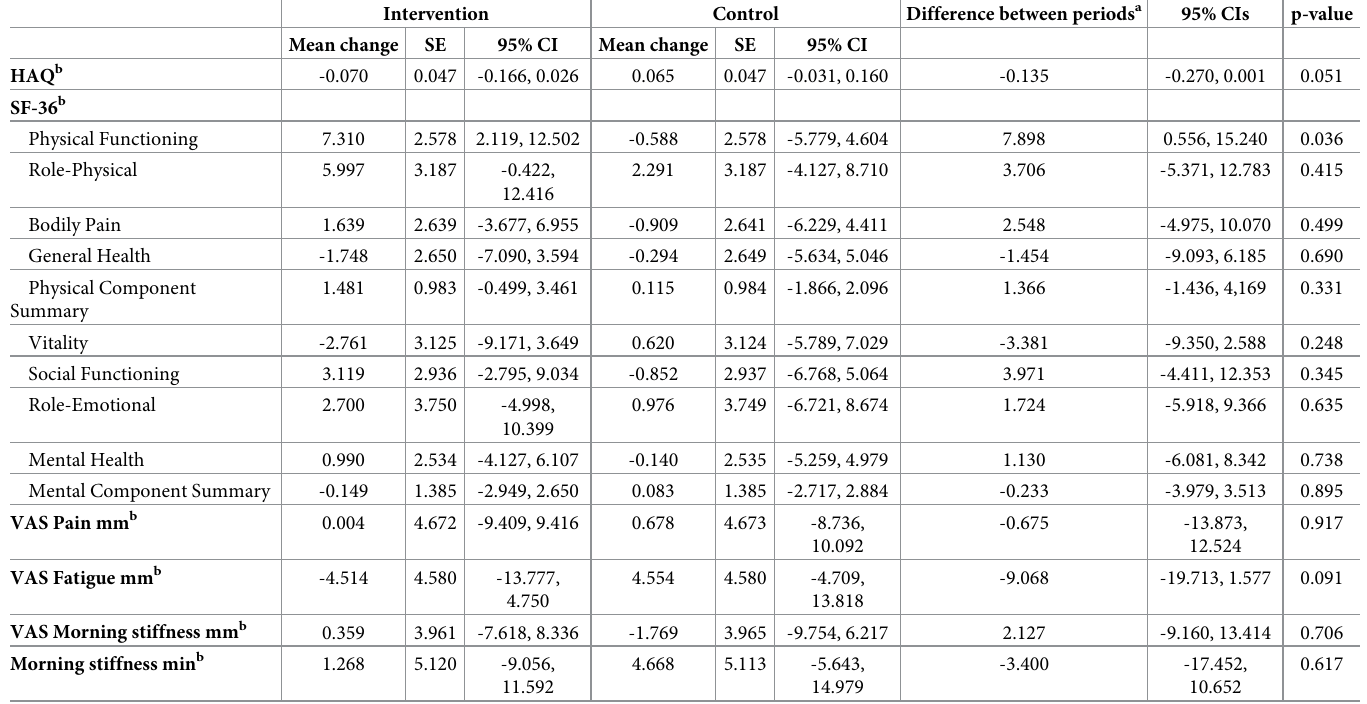
Table 4. The effects on HrQoL in participants without medication changes in the ADIRA